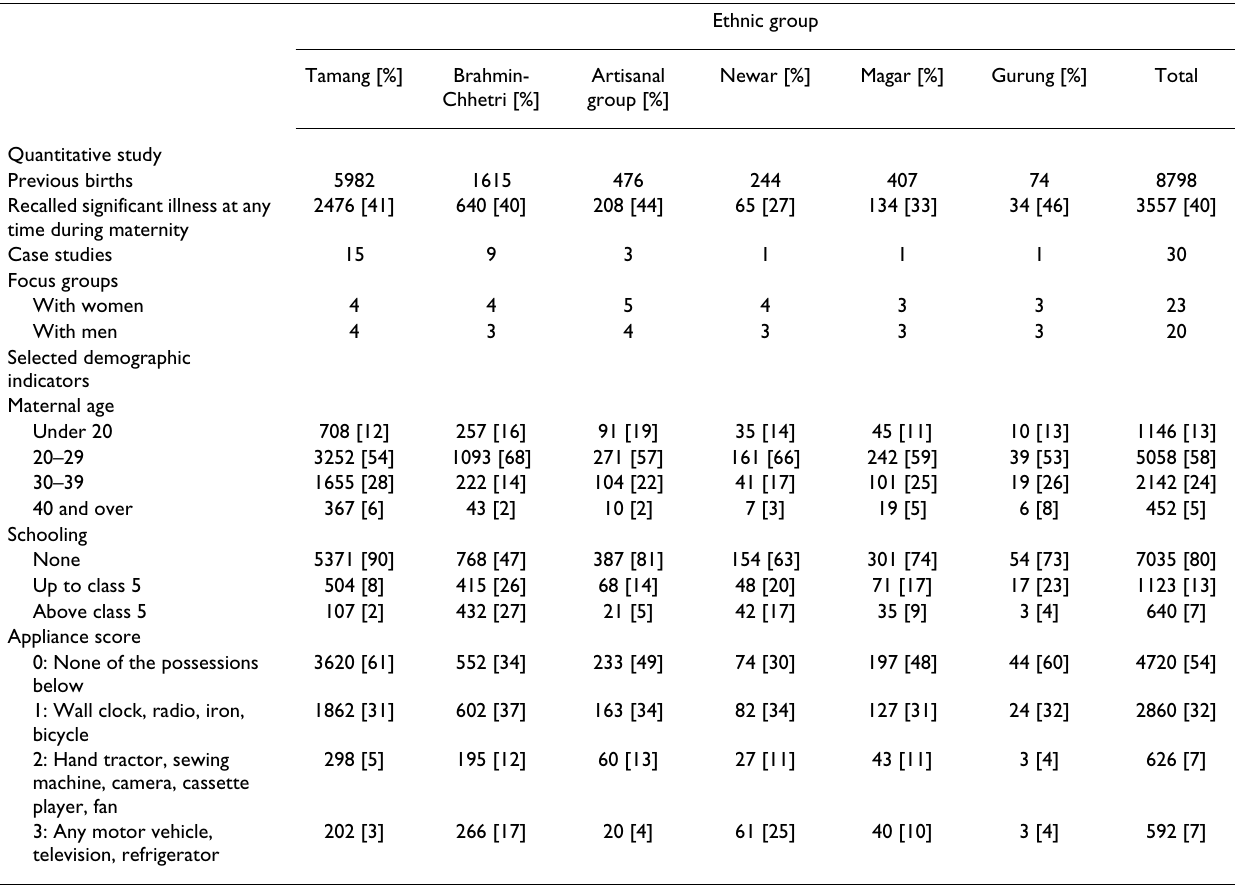
Table 1: Participants in the three components of the study, with selected demographic